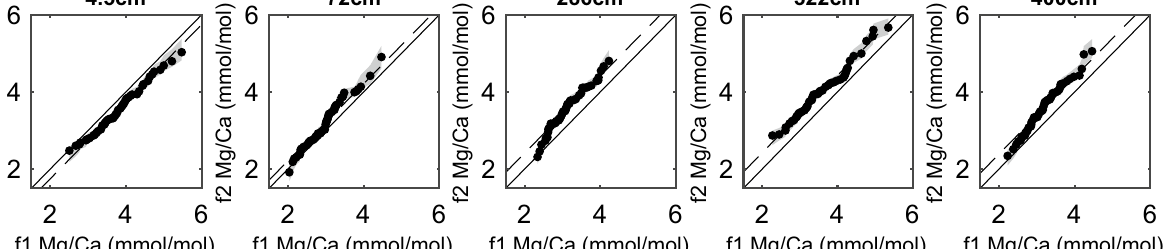
Figure 4. Quantile–quantile analysis of Mg/Ca values from different chambers. Identical distributions will fall along the 1:1 line (solid black diagonal), those that differ in mean will fall along the dotted line, which runs through the median of the y-axis population. Shaded regions depict the analytical uncertainty about the calculated quantiles. Population differences are largely observed at the low Mg/Ca ends of the